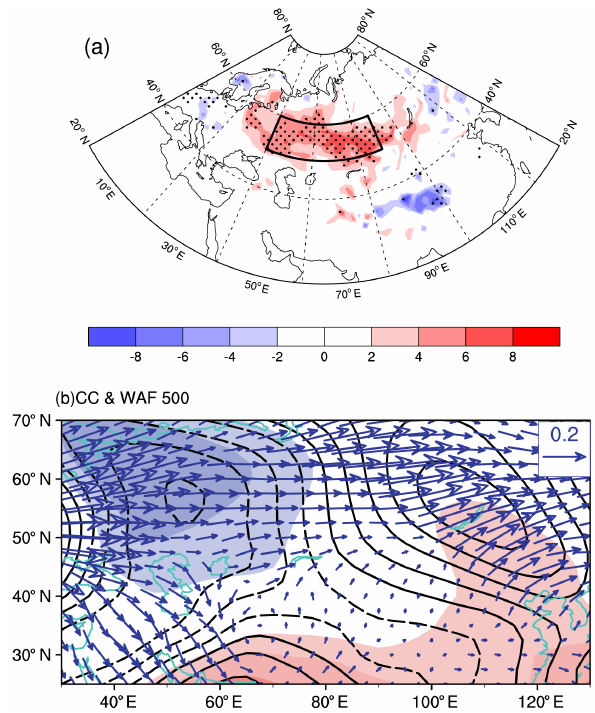
Figure 12. (a) The correlation coefficients (shading) between the October–November snow cover and DHD NH . The dots indicate the correlation coefficients exceeding the 95% confidence level ( t -test), and (b) the correlation coefficients between snow WS and Z500 ex- ceeding the 90% confidence level (shading), correlated WAF (ar- row), and quasi-geostrophic stream function (contour) at 500hPa in December.